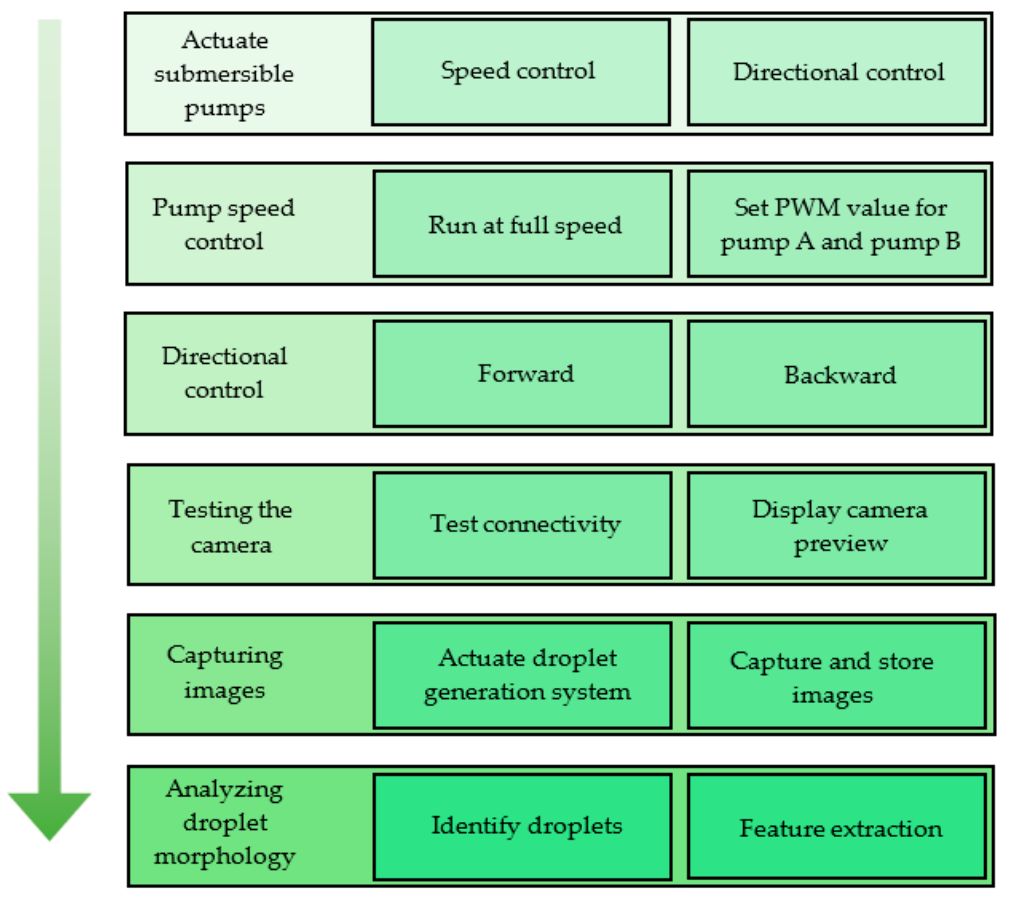
Figure 7. Functionalities of the system and features of the GUI.